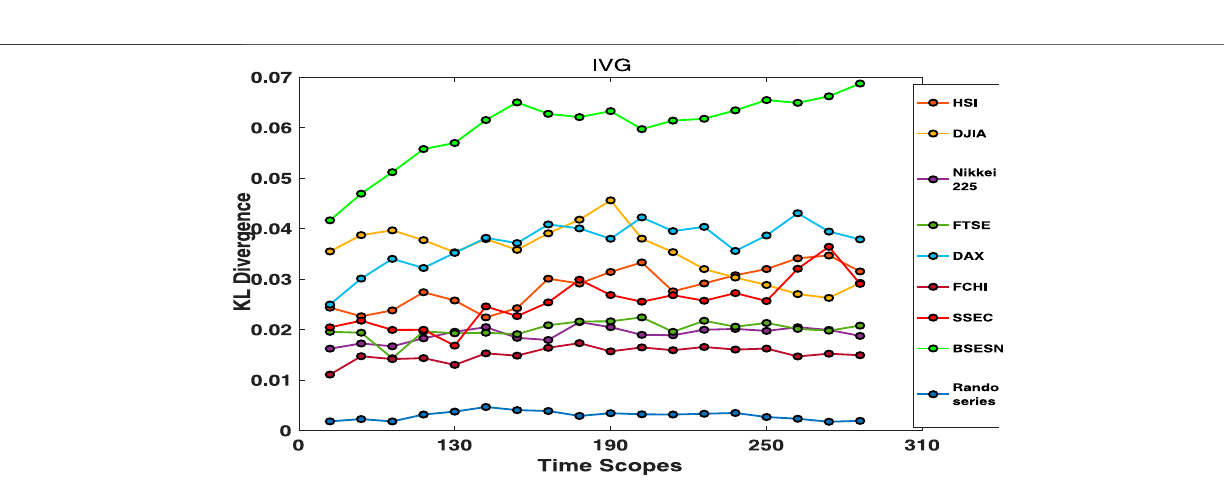
Frontiers in Physics |